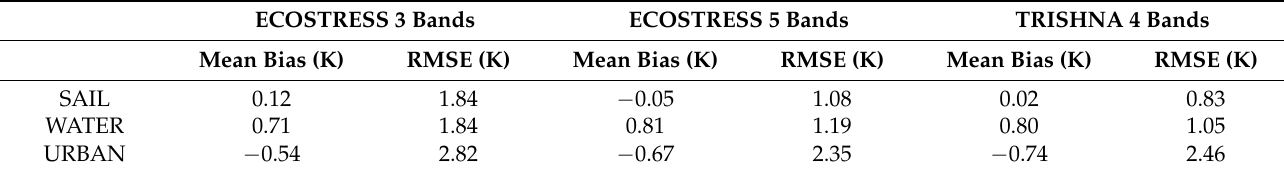
Table 3. Comparison of DirecTES usage on ECOSTRESS (3 or 5 bands) or TRISHNA (4 bands) using the TIR information only and both atmospheric and sensor uncertainties.